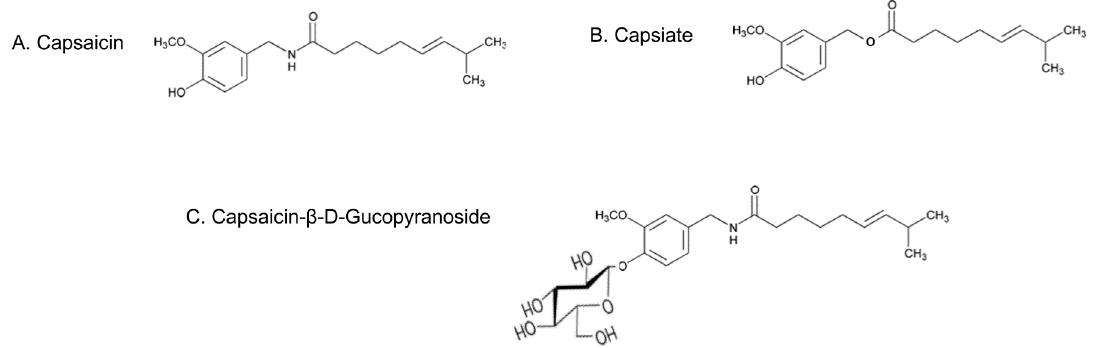
Figure 1. Chemical structures of pungent and nonpungent analogs of CAP. Illustrations of the structures of capsaicin ( A ); ( E )- N -[(4-hydroxy-3-methoxyphenyl) methyl]-8-methylnon-6-enamide; Capsiate ( B ); ( E )- N -[(4-hydroxy-3-methoxyphenyl) methyl]-8-methylnon-6-enoate and Capsaicin- β - D -glucopyranoside ( C ); ( E )- N -[(4- β - D -glucopyranosyloxy)-3-methoxyphenyl) methyl]-8-methylnon- 6-enamide.